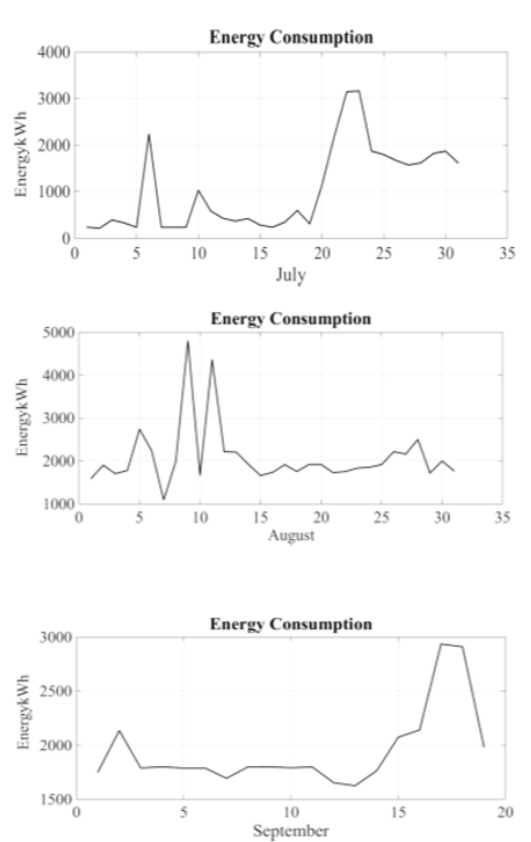
Figure 7: The energy consumption of the room 802 in 3